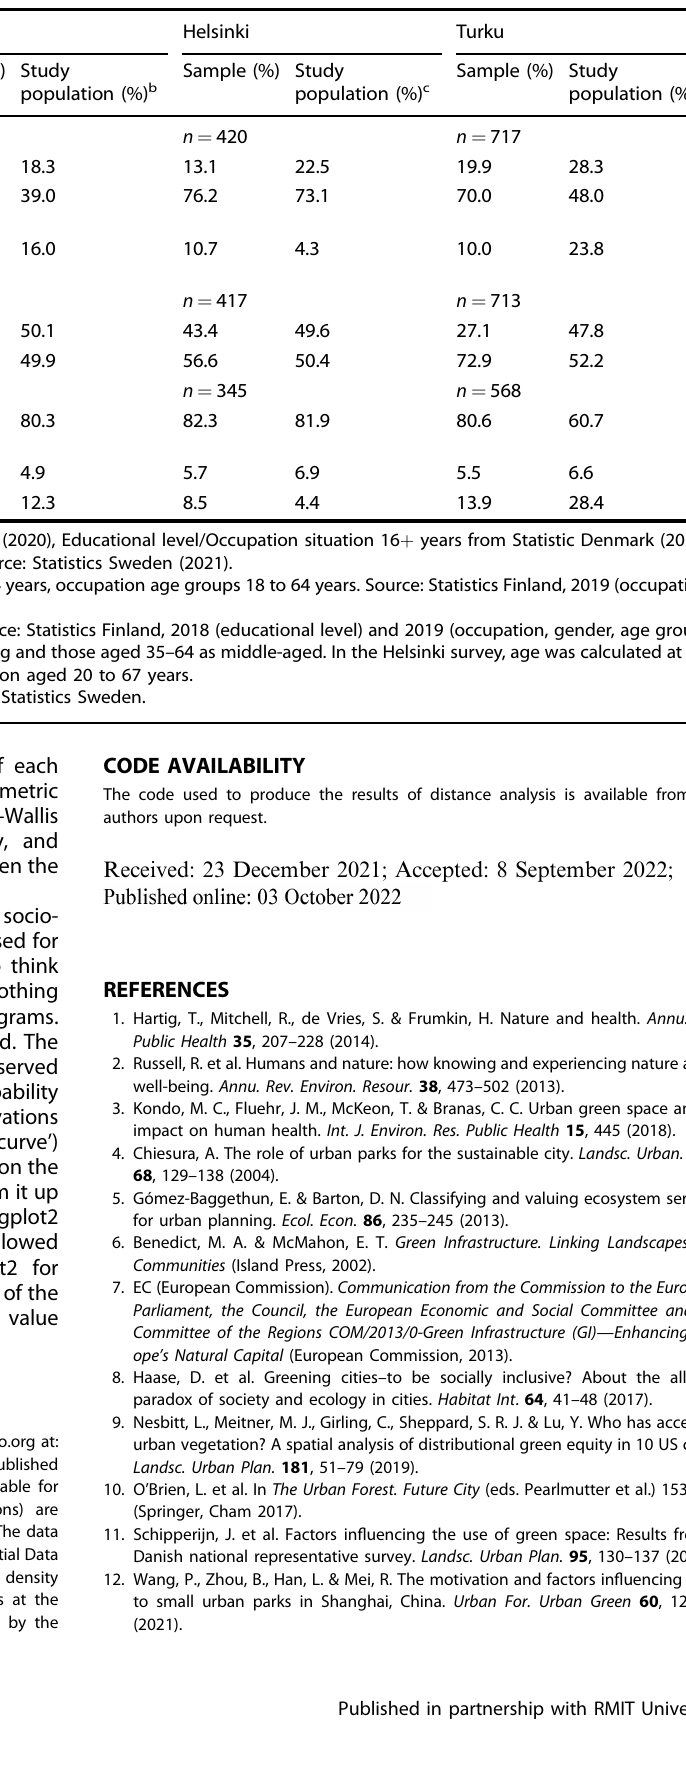
Table 2. Socio-demographic characteristics in sampled data with comparison to the population in the study